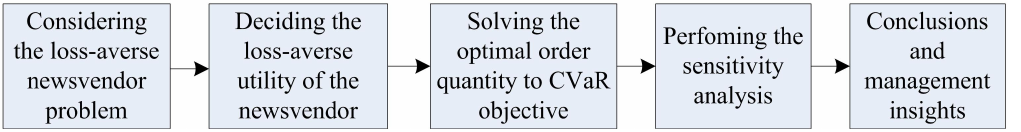
Figure 1. The flowchart of this